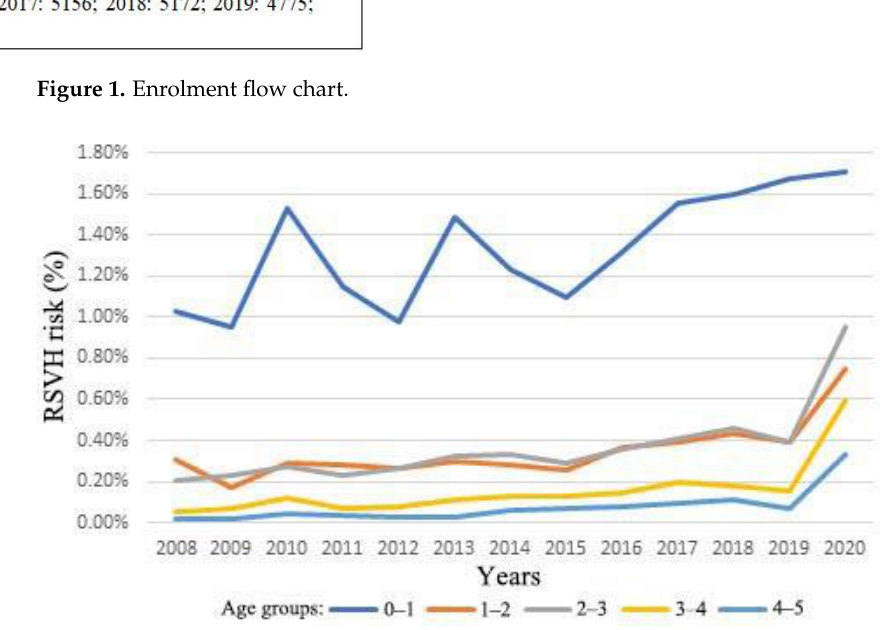
Figure 2. Annual incidence of RSVH among 0–5-year-old children. Children aged 0–5 between